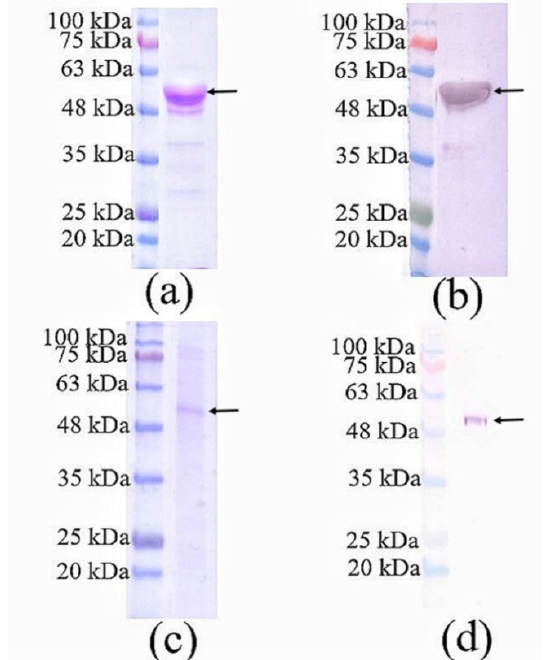
Figure 1. SDS-PAGE and western blotting analysis of Nc-aD produced in Sf 9 cells and purified using immobilised metal affinity chromatography. ( a ) SDS-PAGE and ( b ) western blotting of Nc-aD purified from the culture supernatant of the Sf 9 cells infected with 10% of the baculovirus stock. ( c ) SDS-PAGE and ( d ) western blotting of Nc-aD purified from the cell pellet of the Sf 9 cells infected with 10% of the baculovirus stock. A protein band of ~52 kDa in size was detected as indicated by the arrows. Western blotting was performed with the anti-His monoclonal antibody.